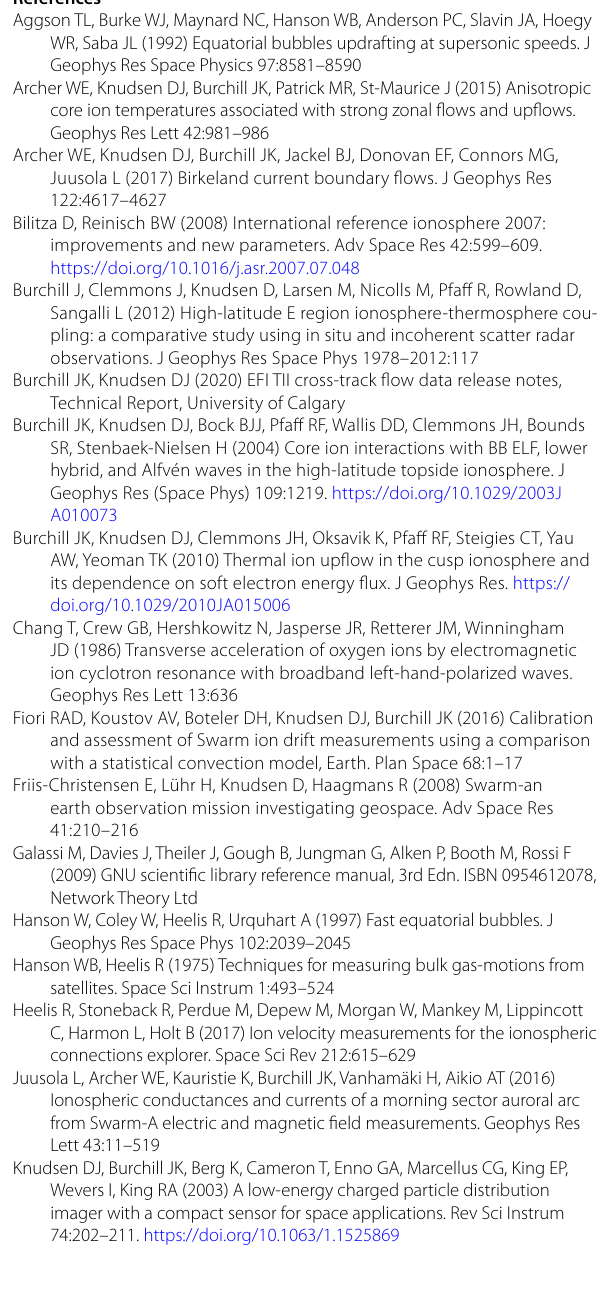
mission Swarm A and C altitude of 300 km (Fig. 28c).